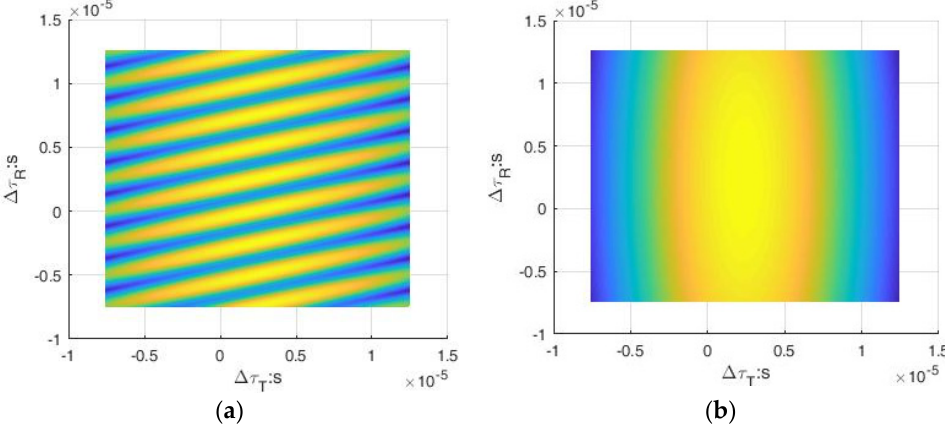
Figure 1. Integrated cross correlation spectrum at SNR = 20 dB. ( a ) Coherent integration. ( b ) Non-coherent integration.